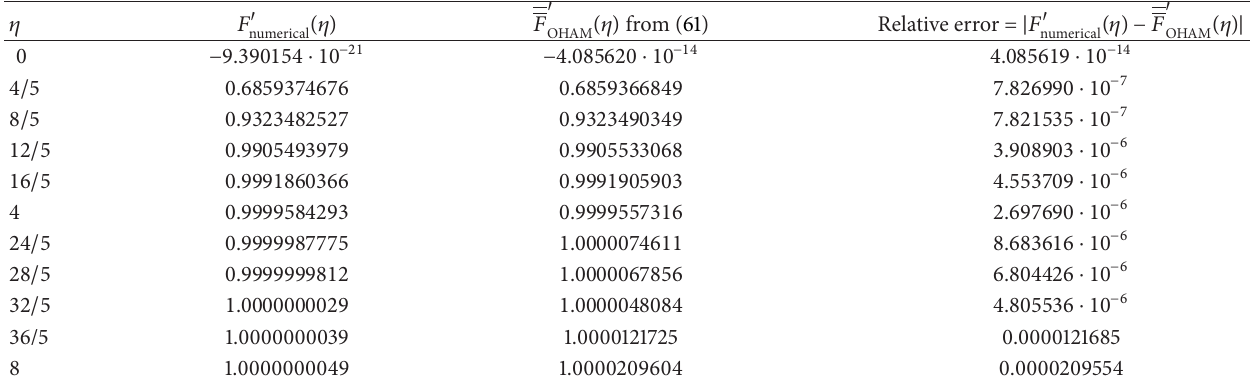
Table 15: Comparison between OHAM results for velocity 𝐹 𝜂 𝐹 󸀠 numerical